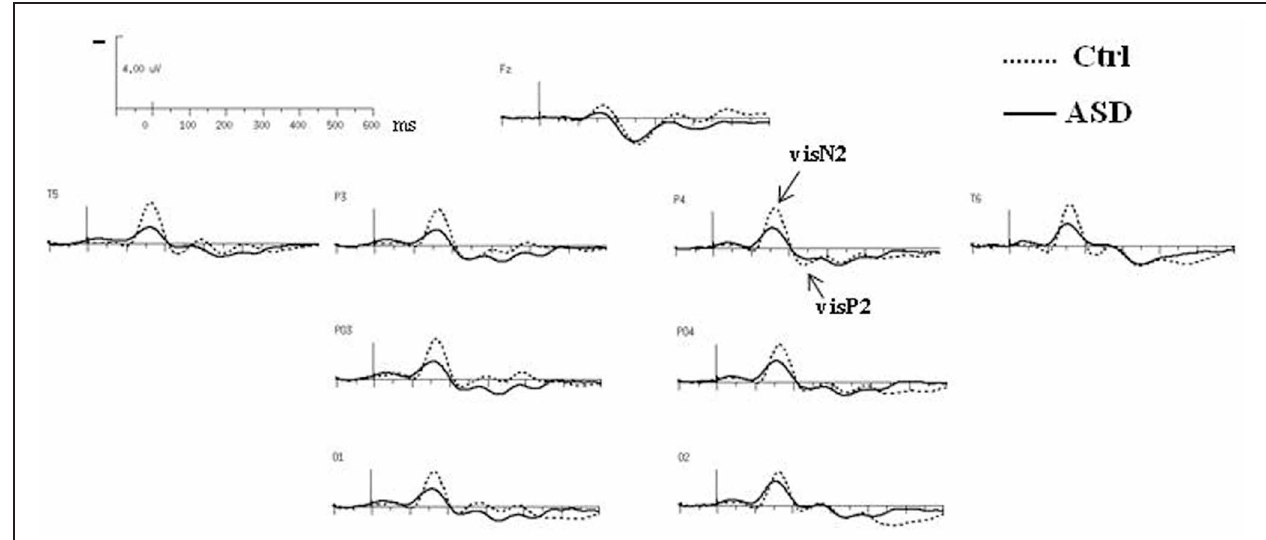
FIGURE 2 | Grand-average ERPs to the standard visual stimuli in both groups at selected